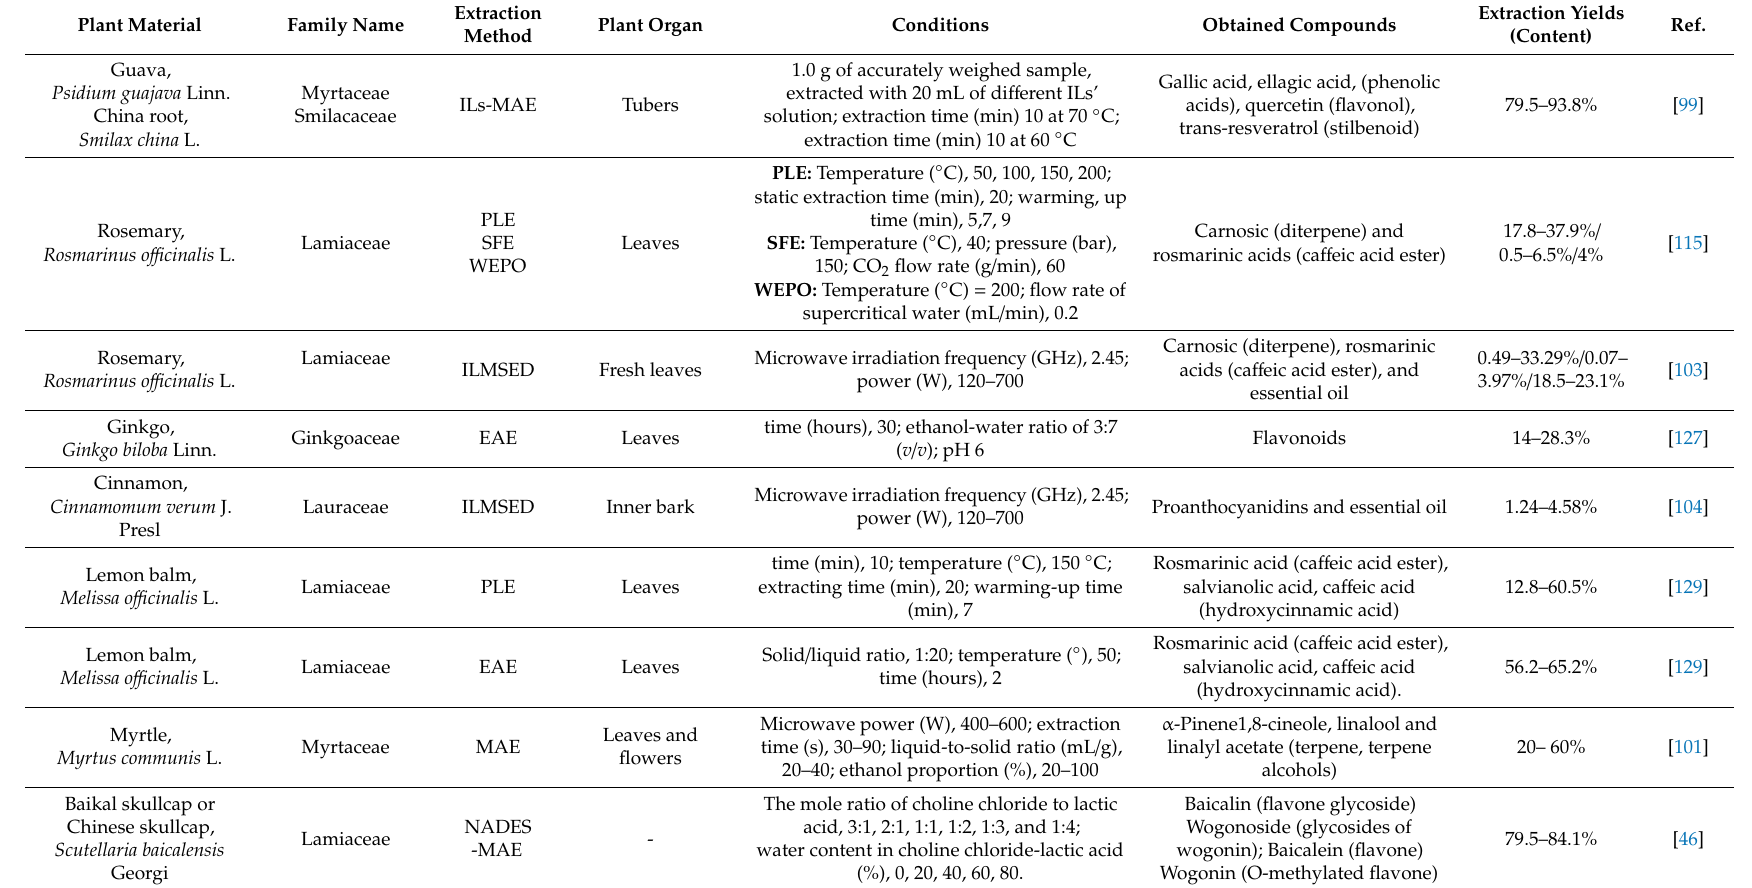
Table 4. Modern extraction methods applied to di ff erent plants material and the obtained compounds (in chronological order of the cited works). Plant